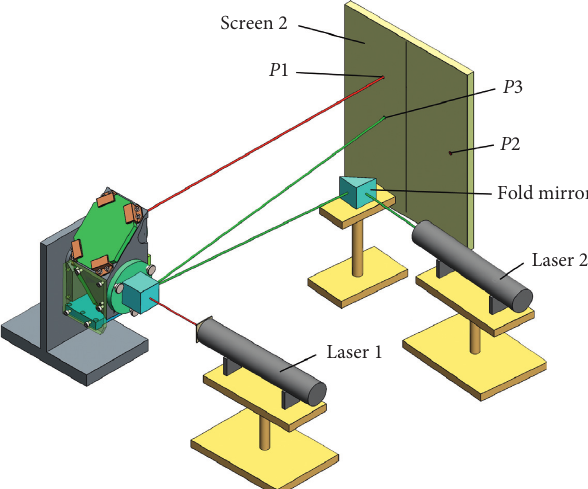
Figure 12: Adjustment of the TSM (Step 3).